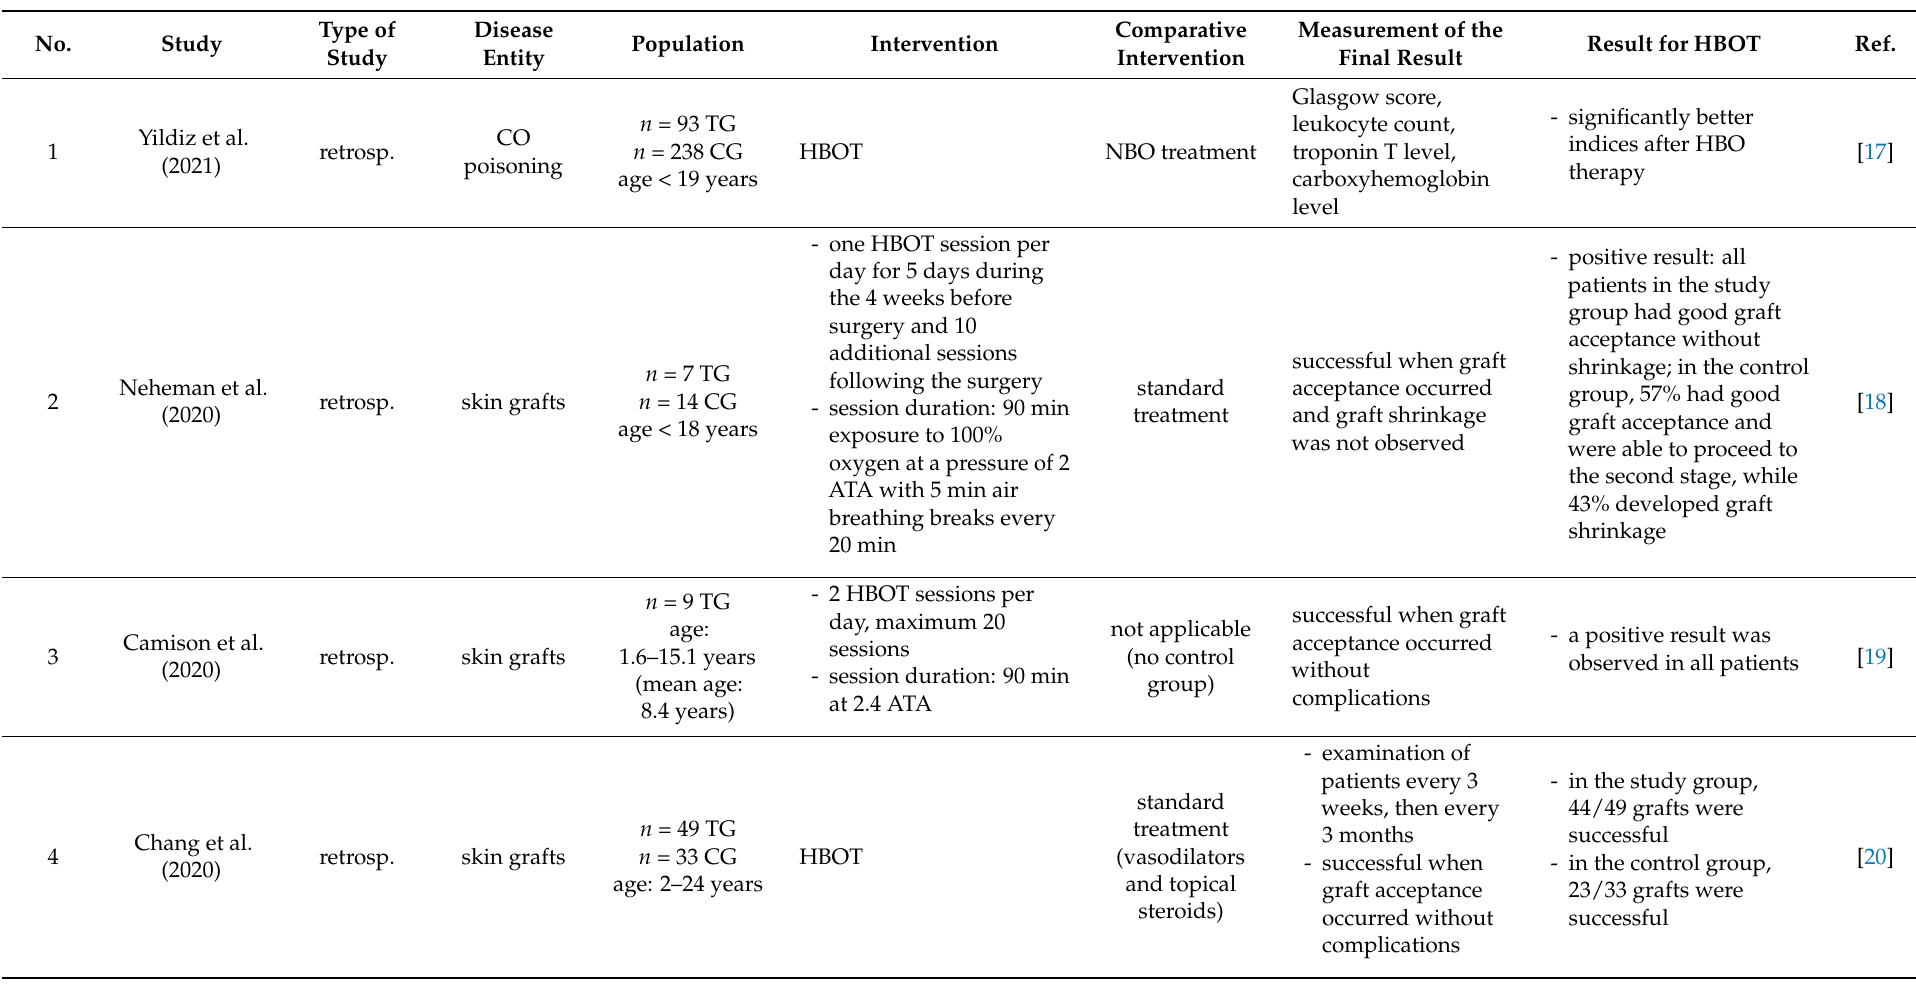
Table 1. A detailed summary of study